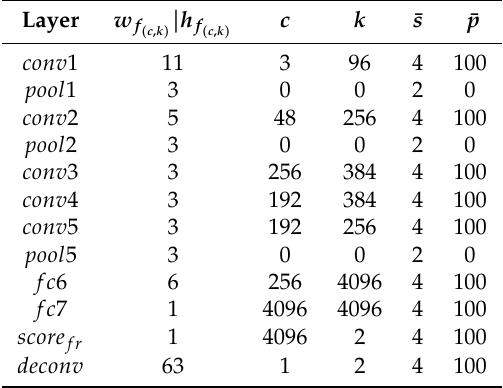
Table 1. Detailed layers of Transferable Fully Convolutional Network (T-FCN)